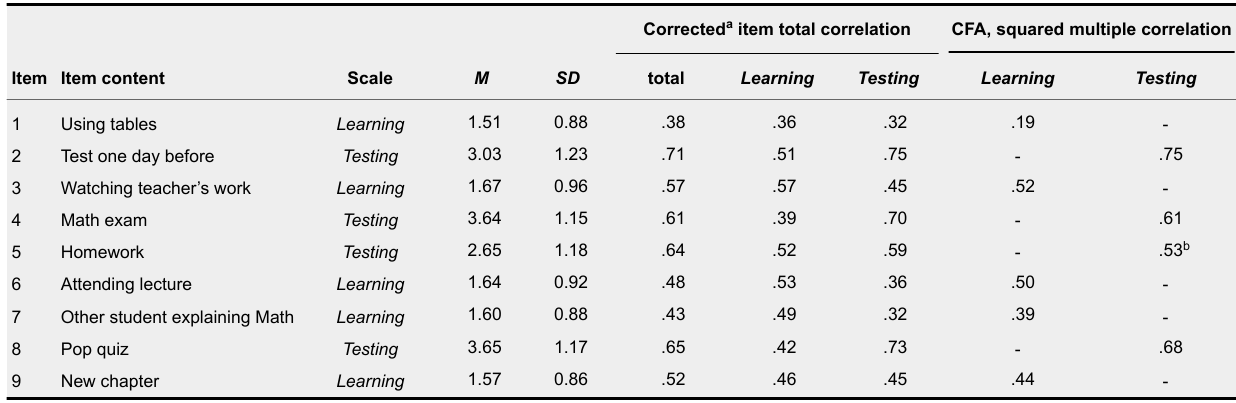
AMAS Item Characteristics and Factor Loadings From Confirmatory Factor Analysis (n =